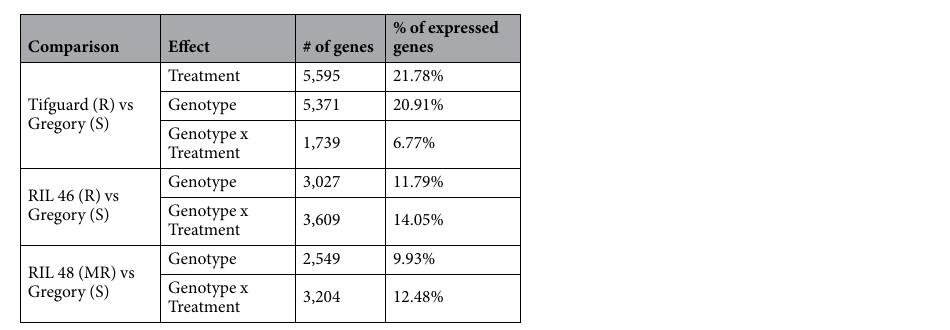
Table 1. Number of differentially expressed genes for each comparison and percentage of differentially expressed genes compared to all expressed genes in the comparison. Effects and interactions were tested using DESeq2 LRT